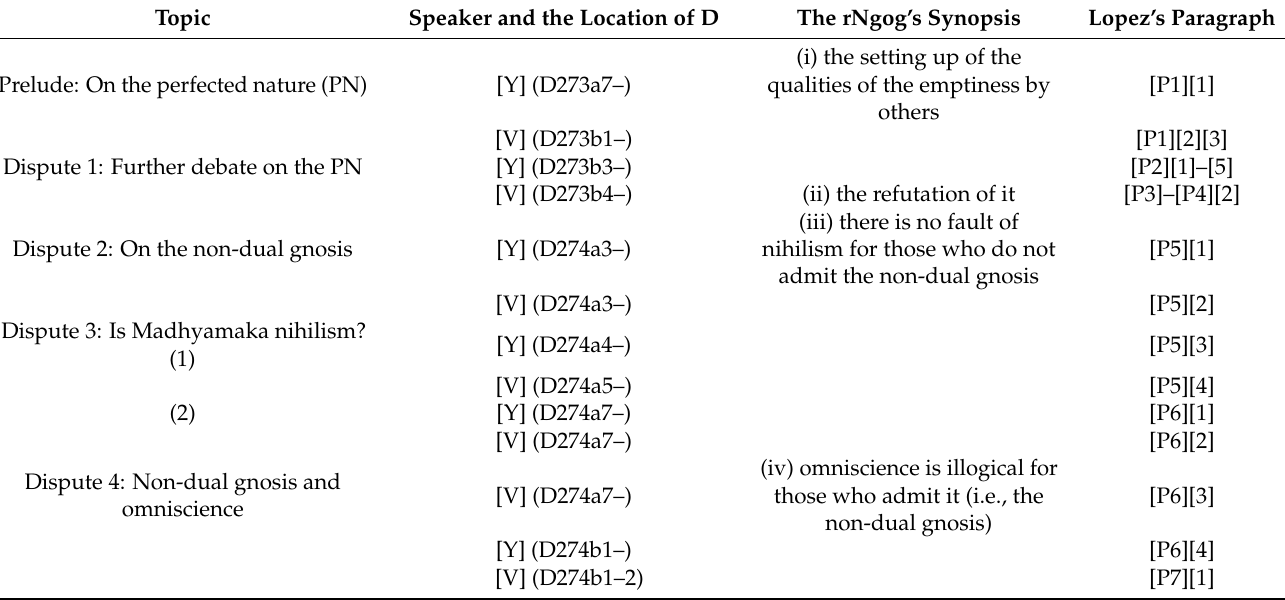
Table 2. My understanding of the subject and speaker of the passage: in contrast to the rNgog and Lopez.